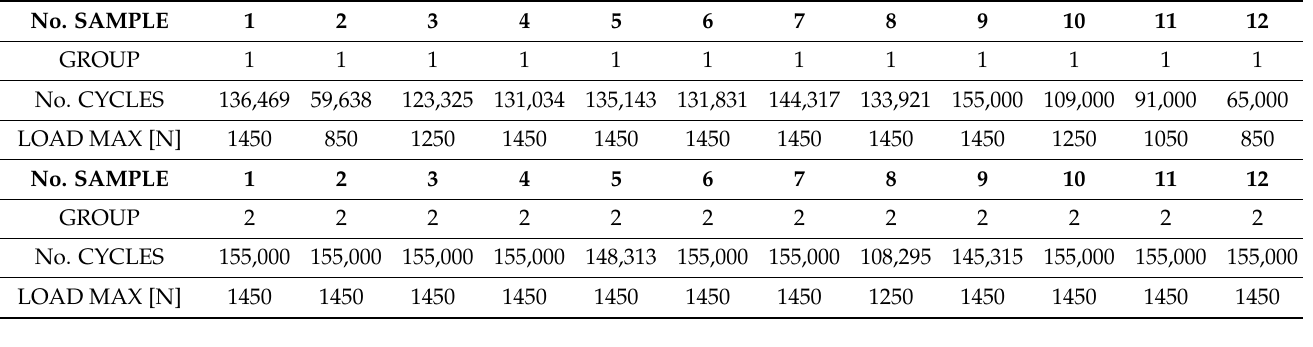
Table 2. Fatigue test results (n = 12). Table 1. Strength calculated from static testing (n = 3).